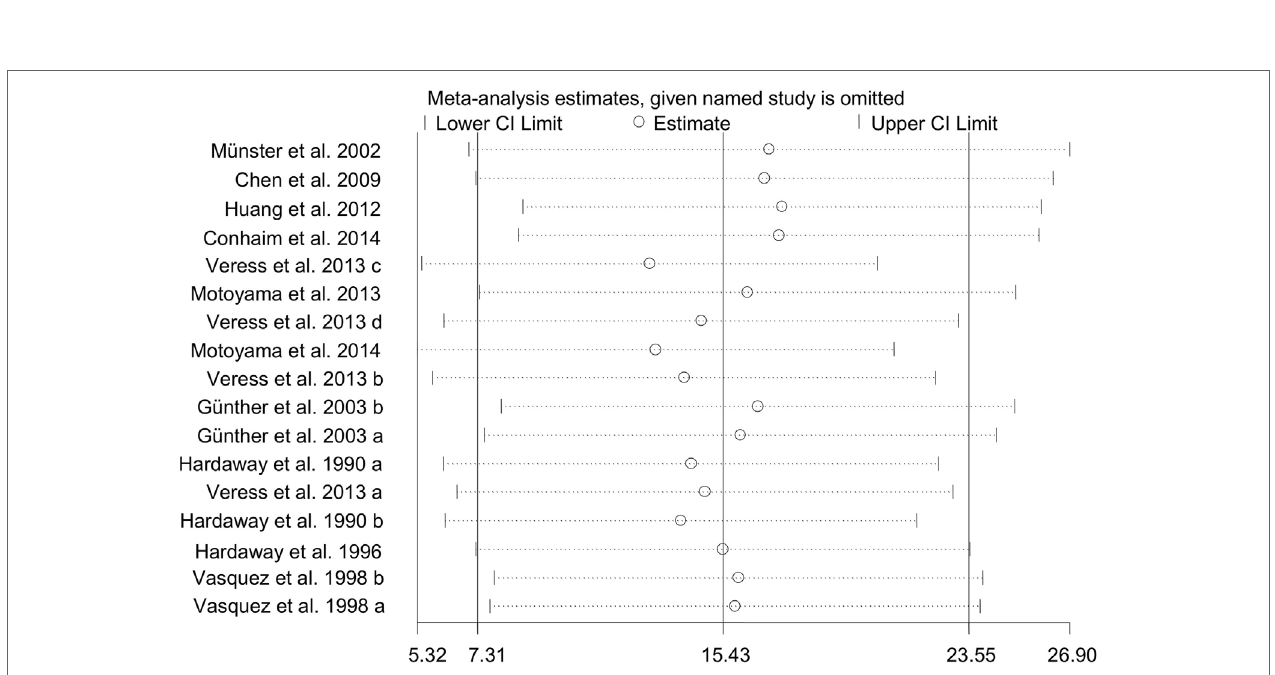
FiGURe 8 | Sensitivity analysis of PaO 2